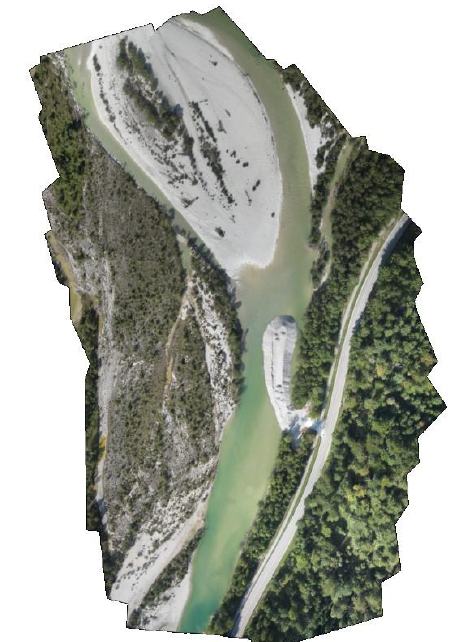
Figure 12 Orthomosaic of Alpine river environment